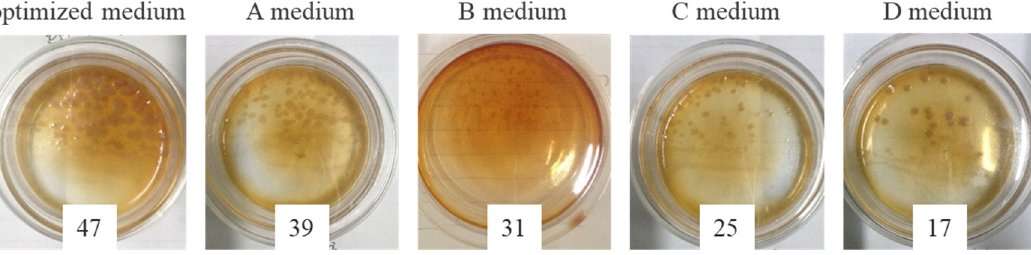
Figure 8. Images of the viable cell concentration method showing the biofilm growth (10 6 times dilution).